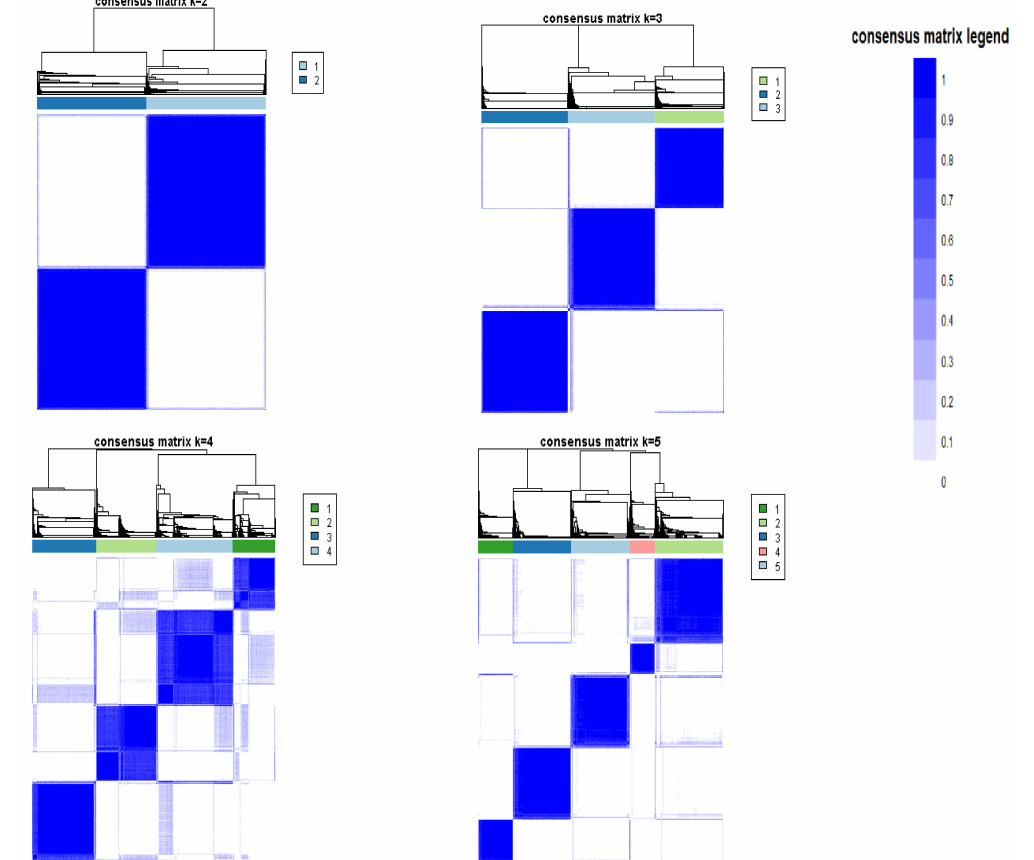
Figure 2. Consensus matrix heat map depicting consensus values on a white to blue color scale of each cluster.